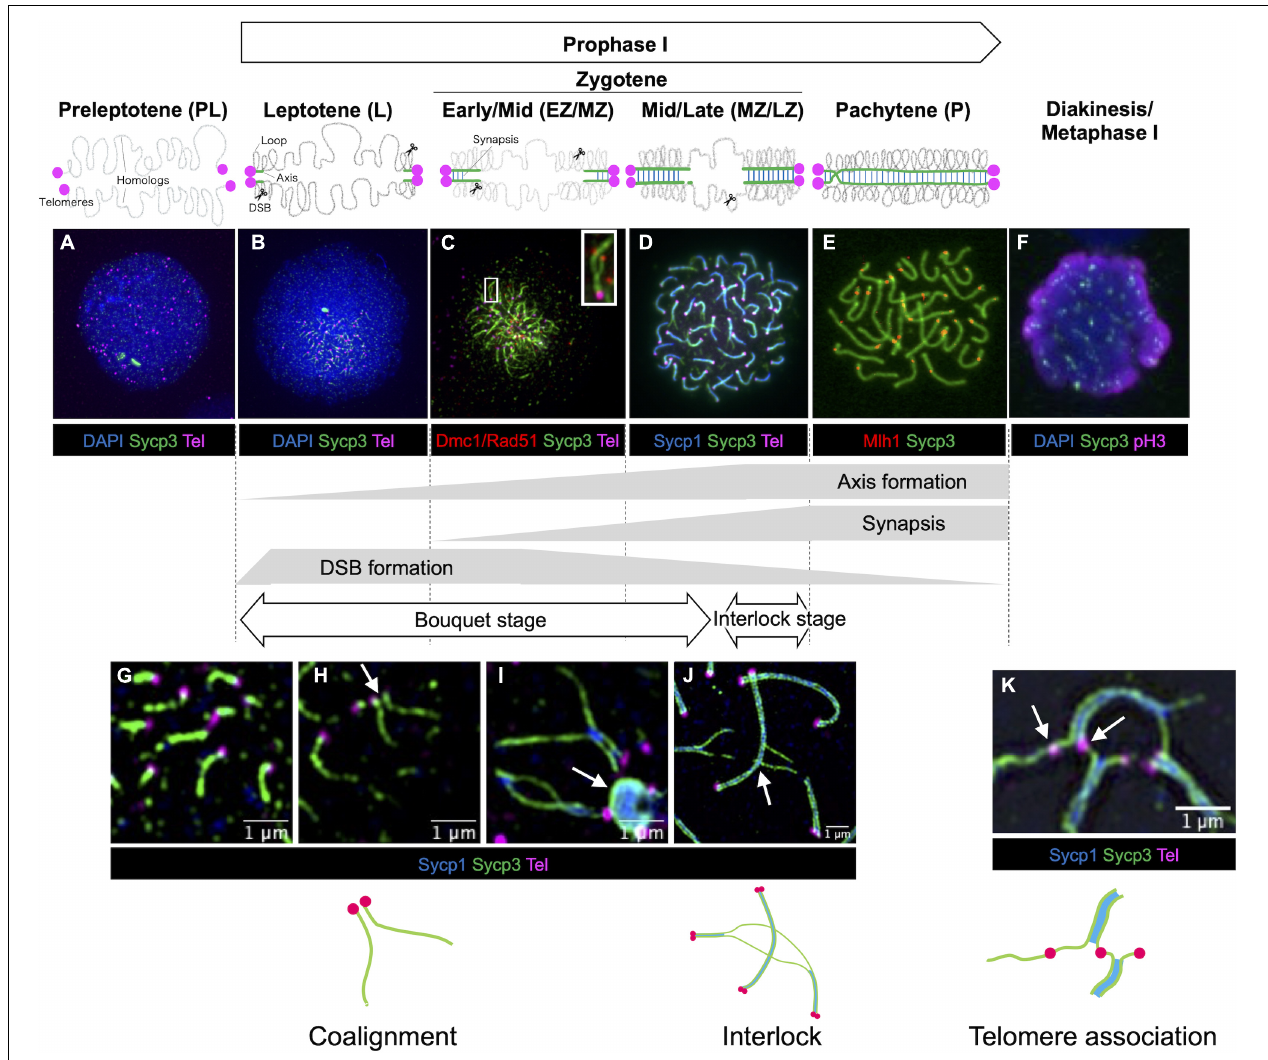
FIGURE 2 | Stages of meiotic prophase I in zebrafish. Immunofluorescence staining of synaptonemal complex protein 3 (Sycp3) with telomeres (Tel), DNA (DAPI) and/or stage specific markers on zebrafish spermatocyte spreads observed by conventional immunofluorescence microscopy (A–F) and by super resolution microscopy (G–K) . Diagrams of homologous chromosome pairs (gray lines) indicate axis formation (green lines) and synapsis (blue lines) from telomeres (circles in magenta). (A) In the preleptotene stage, telomeres are yet to cluster and aggregates of Sycp3 are observed. (B) In the leptotene stage, telomeres cluster in the bouquet and axis formation as seen by the formation of Sycp3 lines immediately adjacent to telomeres. (C) DSBs near telomeres in leptotene and early/mid-zygotene (EZ/MZ) stages, visualized by staining DNA recombinases (Dmc1/Rad51; adapted from Takemoto et al., 2020). A region marked as a white rectangle is shown at a higher magnification at the top right. (D) Synapsis between homologs visualized by synaptonemal complex protein 1 (Sycp1) staining in a mid- to late zygotene (MZ/LZ) nucleus. (E) In the pachytene stage, axis formation and synapsis are completed and chromosomes are aligned from end-to-end. Future crossover sites are visualized by staining of MutL homolog 1 (Mlh1), which is involved in DSB repair. (F) A phosphohistone H3 (pH3) positive nucleus with broken Sycp3 signals. (G) Axes originate from telomere regions. (H) Coaignment between homologs, as indicated by parallel segments of axes (arrow). (I) Synapsis initiates between end regions. Telomeres are often seen associated with polycomplexes made up of Sycp3 and Sycp1 proteins (arrow). (J) End-to-end synapsis can result in interlocks where one or two chromosomes (in this case two synapsed homologs) can be trapped between another synapsed pair (arrow). Interlocks are often seen with local regions of asynapsis. (K) Telomere associations can persist into zygotene (shown here) and pachytene (not shown) although their numbers are reduced. Sometimes a stretch of axis can be seen spanning the ends of two unrelated chromosomes (arrow). Schematic diagrams of chromosome configurations are shown at the bottom. In (A,B,F) blue indicates DAPI stained DNA while in (D,G–J) blue indicates Sycp1 protein. (C) Is adapted from Takemoto et al. (2020). (F) Is modified from Ozaki et al. (2011). (G–I) Were previously published in Blokhina et al. (2019). (A,B,D,E,J) Replicate previously published